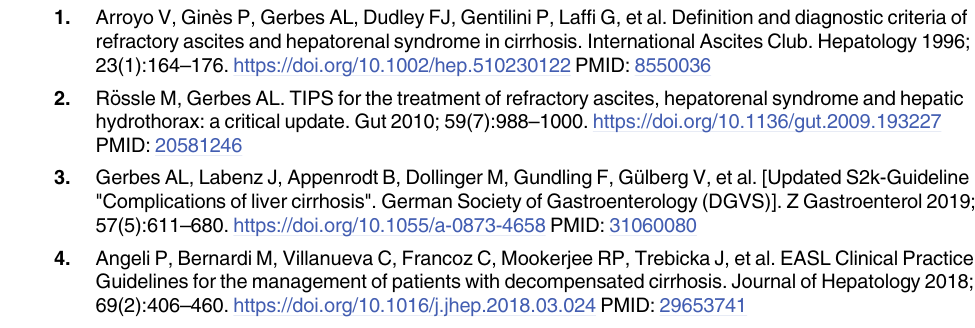
S2 Table. A. Causes of death of TIPS patients dying within 90 days after TIPS insertion. B. Causes of death of TIPS patients dying within 1 year after TIPS insertion. S3 Table. Univariate Cox regression analyzing risk factors for (a) 28-day, (b) 90-day and (c) 1-year survival after TIPS insertion in the subgroup of patients � 65